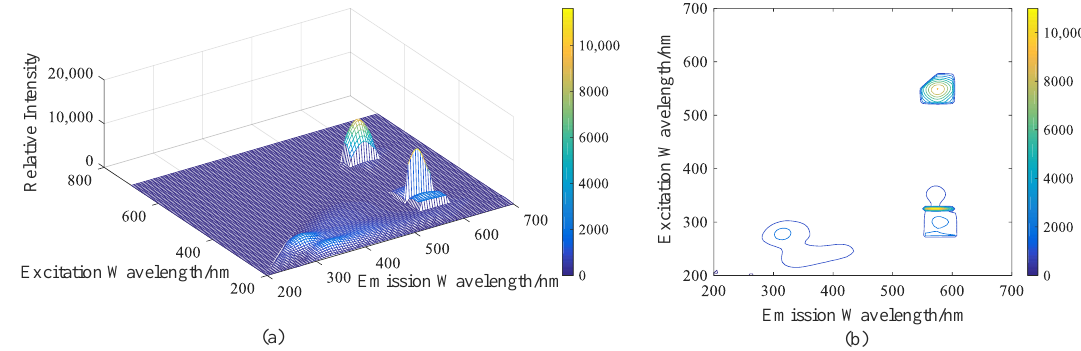
Figure 9. 3D ( a ) and contour ( b ) diagrams of 20 μg/L rhodamine B positioning result.